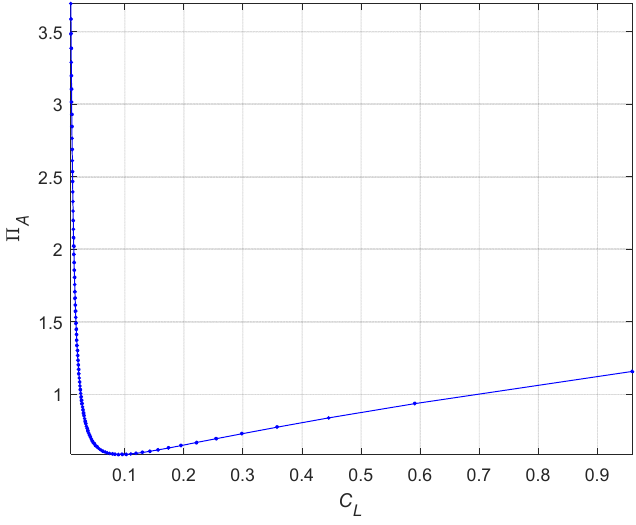
Figure 7. Plot of Π A as a function of C L for an albatross, showing the optimal value of C L .